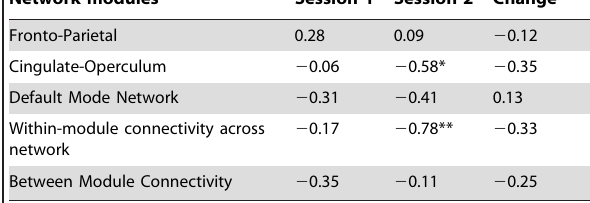
Table 2. Correlations between VSTM capacity and intra- module connection density, and between module